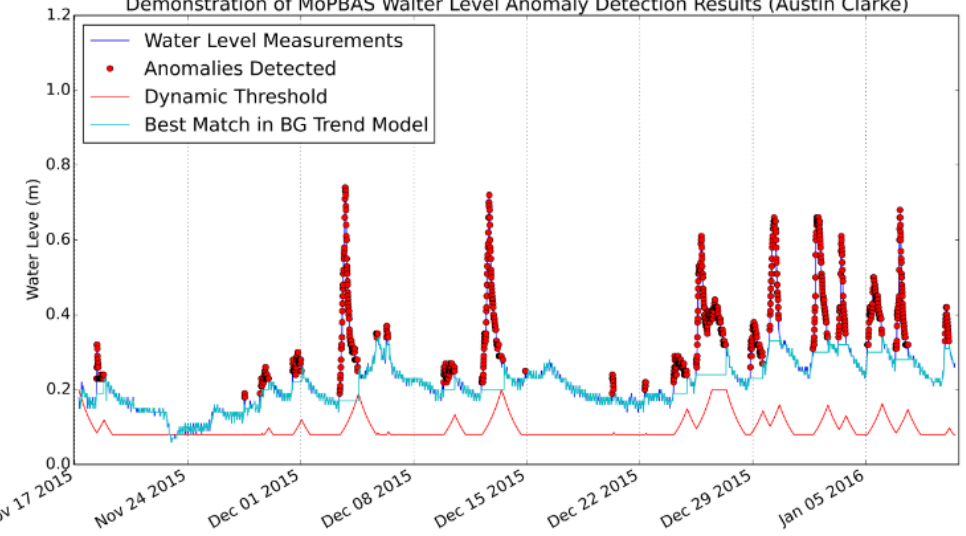
Figure 8. Demonstration of MoPBAS anomaly detection results at Austin Clake site with dynamic threshold and background (BG) trend model.